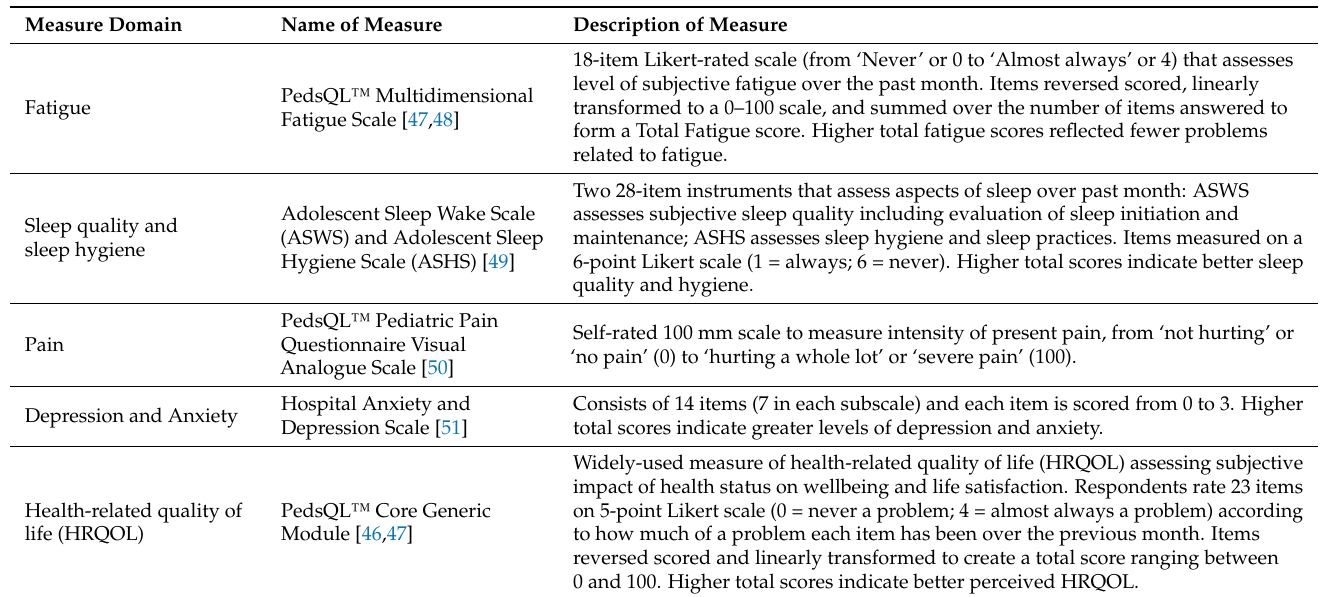
Table 1. Measures to evaluate health and psychological wellbeing in adolescents with ME/CFS and healthy controls. Measure